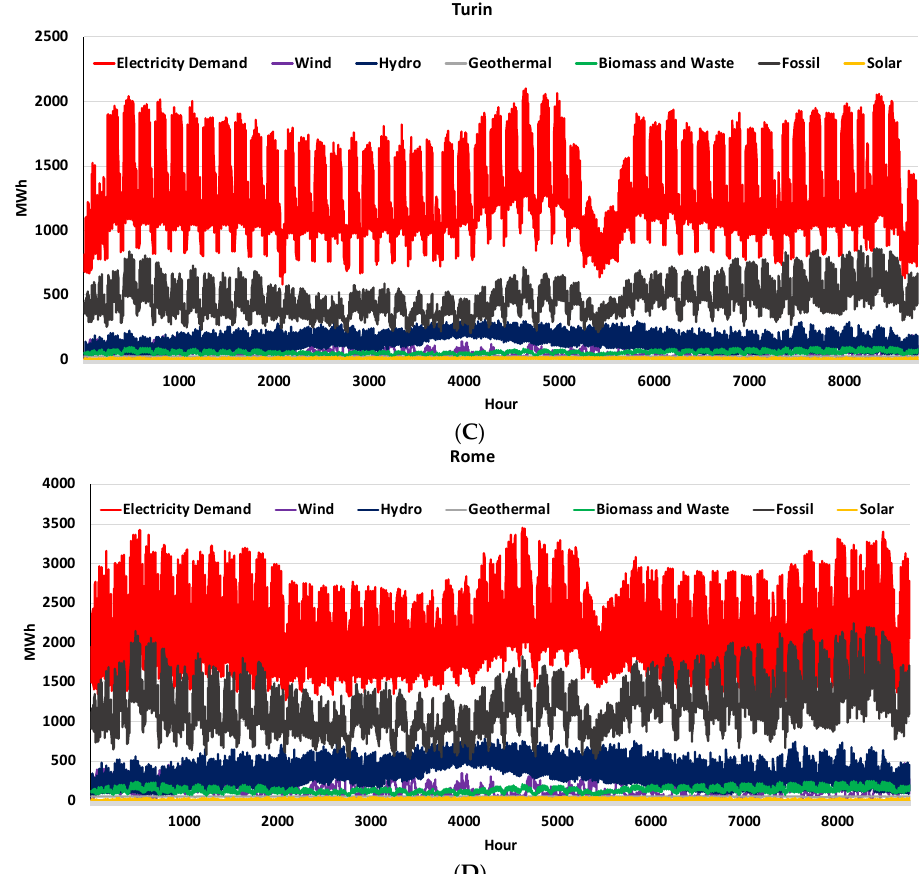
Figure 5. Electricity supply and demand of ( A ) Umeå, ( B ) Stockholm, ( C ) Turin, ( D ) Rome.